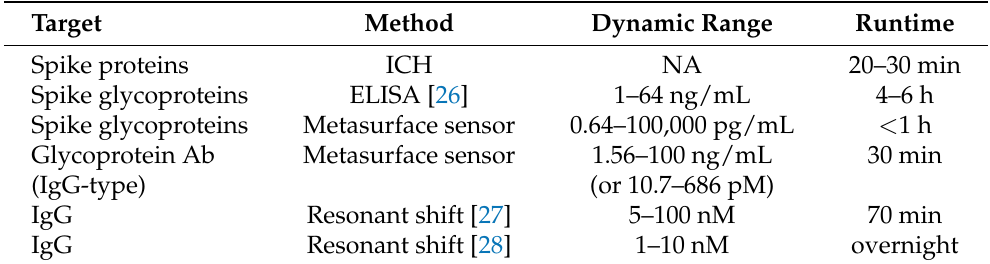
Table 1. COVID-19 detection for proteins and antibody. ICH denotes immunochromatography-based disposable test kits. NA denotes not available. Dynamic range defined in the text is estimated from the published data in the references. Metasurface sensor refers to this study. Runtime includes all the preparation time that is inseparable in a